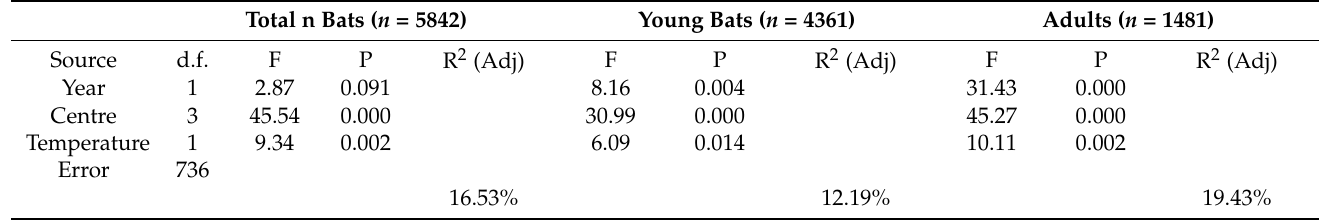
Table 1. Results of a GLM ANCOVA on the total number of bats admitted at four Italian rehabilitation centres in 2000–2021. Temperature = weekly mean of maximum temperatures recorded.